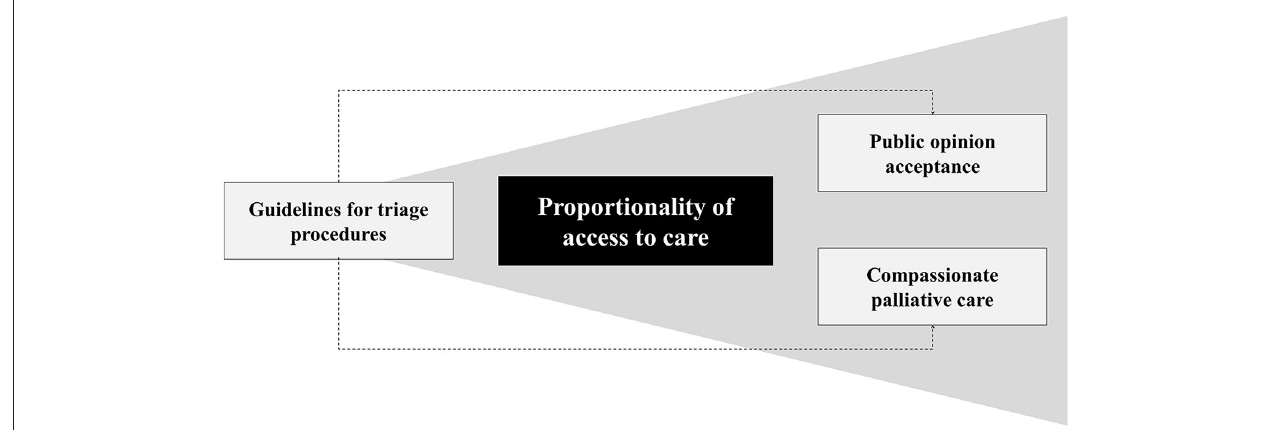
FIGURE 1 | Position statement on proportionality of access to care during